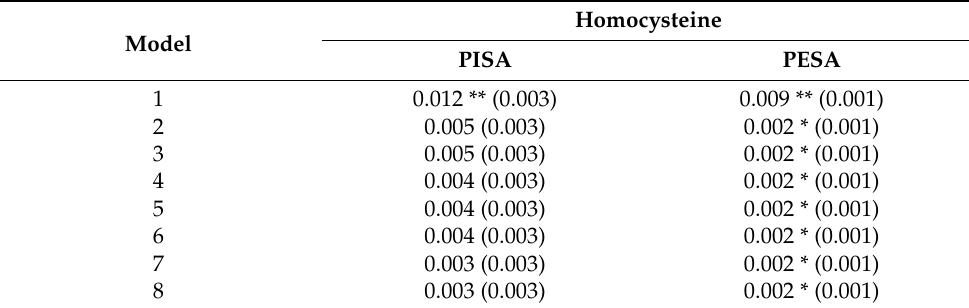
Table 3. Crude and adjusted linear regression models of homocysteine levels and PISA or PESA for the overall sample with the respective B coefficient and standard error (SE) ( n = 4021).